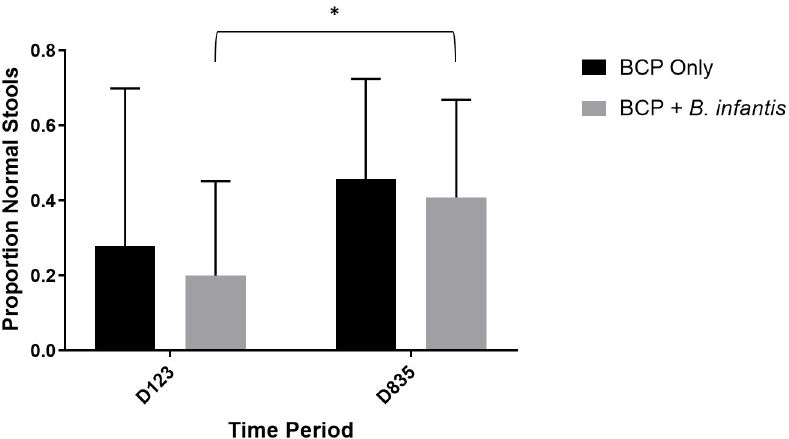
Fig 4. Proportion of normal stools with treatment. Mean ± SD proportion of total recorded stools that were of normal consistency (4 on Bristol Stool Scale), based on stool log data (n = 8 for each group). Significant differences in means (p < 0.05) are denoted by an asterisk. D123, days 1,2 and 3 of the study period (baseline); D835, days 8 through 35 of the study period.